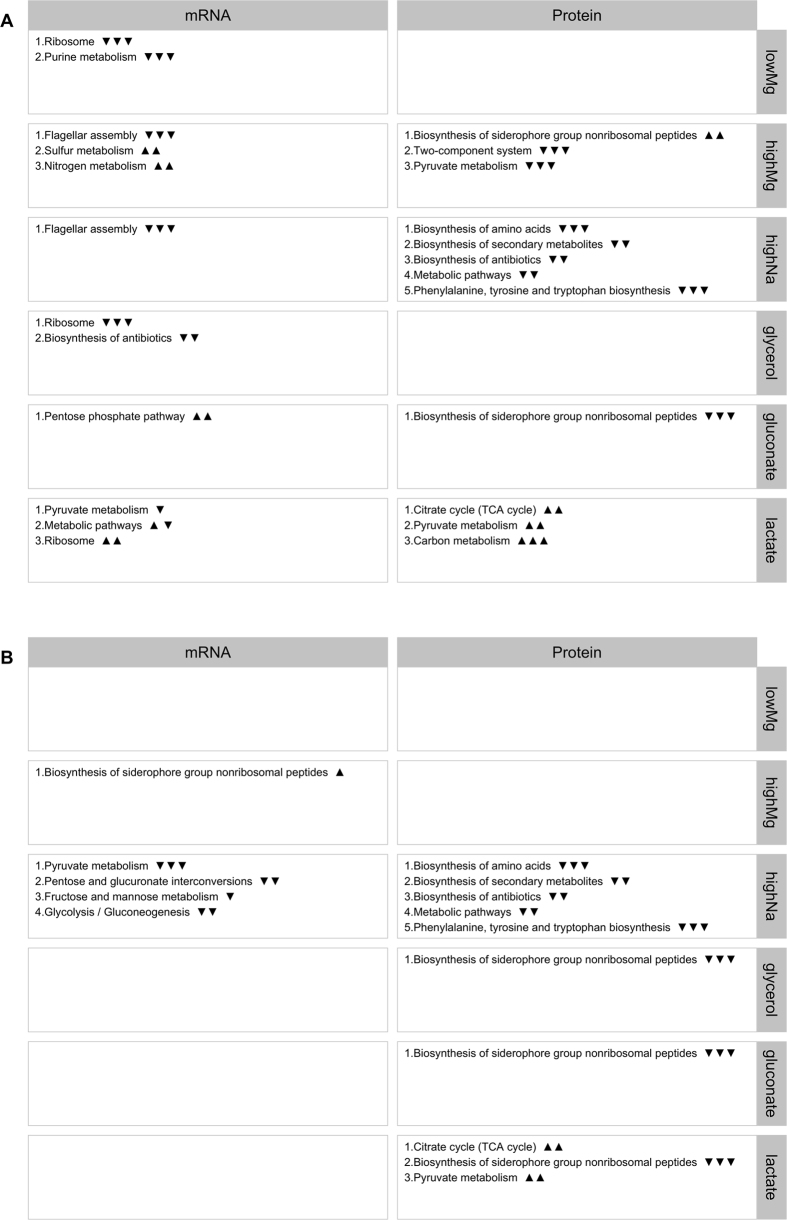
Significantly differentially expressed KEGG pathways.For each condition, we show the top-5 differentially expressed KEGG pathways as determined by either mRNA or protein abundances. Empty boxes indicate that no differentially expressed pathways were found. The arrows next to pathway names indicate the proportion of up- and down-regulated genes among the significantly differentially expressed genes in this pathway. One up arrow indicates that 60% or more of the genes are up-regulated, two arrows correspond to 80% or more genes, and three arrows correspond to 95% or more genes being up-regulated. Similarly, down arrows indicate the proportion of down-regulated genes. (A) Exponential phase. (B) Stationary phase.